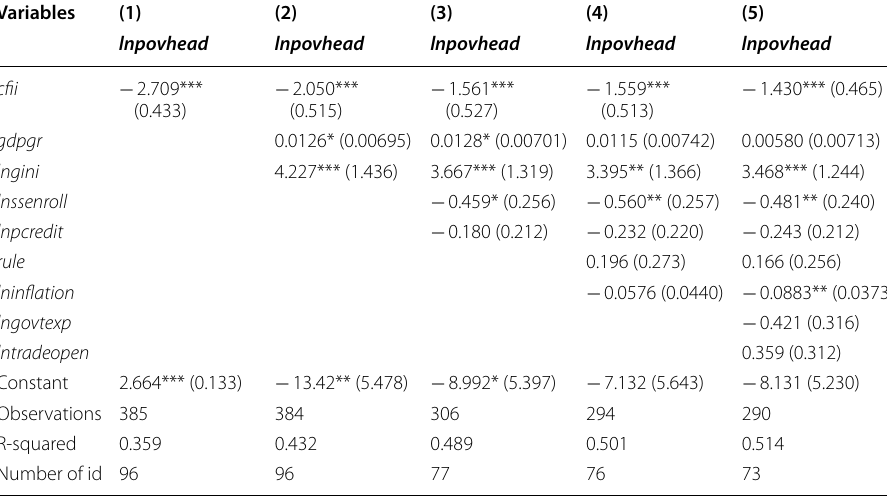
The dependent variable is poverty headcount ratio. For details of the explanatory variables, see Appendix B. All standard errors are robust and reported in parentheses. The symbols ***, **, and * indicate statistical significance at the 1%, 5%, and 10% level,